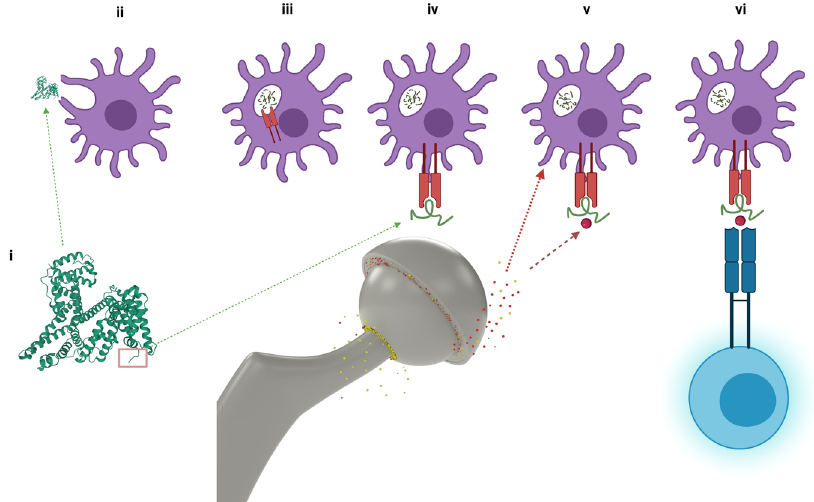
Fig. 7 Pathogenesis of DTH. (i) The N terminal sequence (NTS) of albumin (red rectangle) contains two recognised metal-binding sites. (ii) Endogenous (self-proteins, including albumin) and exogenous (pathogens/ingested substances) proteins are ingested by APCs, which include macrophages and dendritic cells (purple). (iii) The ingested proteins are acidi fi ed in the lysosomes of the APCs(29), where peptidases act to section the original proteins into their shorter, constituent peptides. These peptides compete for the binding groove of class II MHC complexes (red). (iv) If a peptide forms a stable complex with the MHC molecule, the resulting MHC:peptide complex is transported to the cell surface (v) Self-peptides held in the binding groove of an MHC molecule can form complexes with metal ions (dark red sphere) released from implant surfaces (broken dark red arrow) to form haptens. (vi) The MHC:peptide:metal complex may activate T4 lymphocytes resulting in sensitisation. This will happen if the lymphocyte has been activated via pattern recognition receptors (PRRs), which can occur due to local cellular damage through metal toxicity (broken red arrow). Figure created with